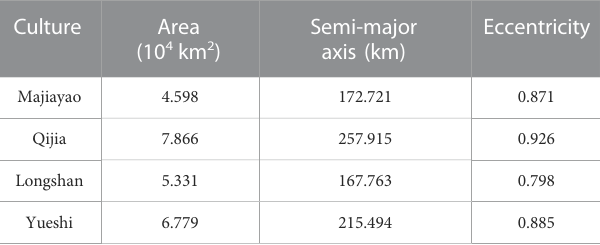
TABLE 3 Parameters of SDEs for archaeological sites of different